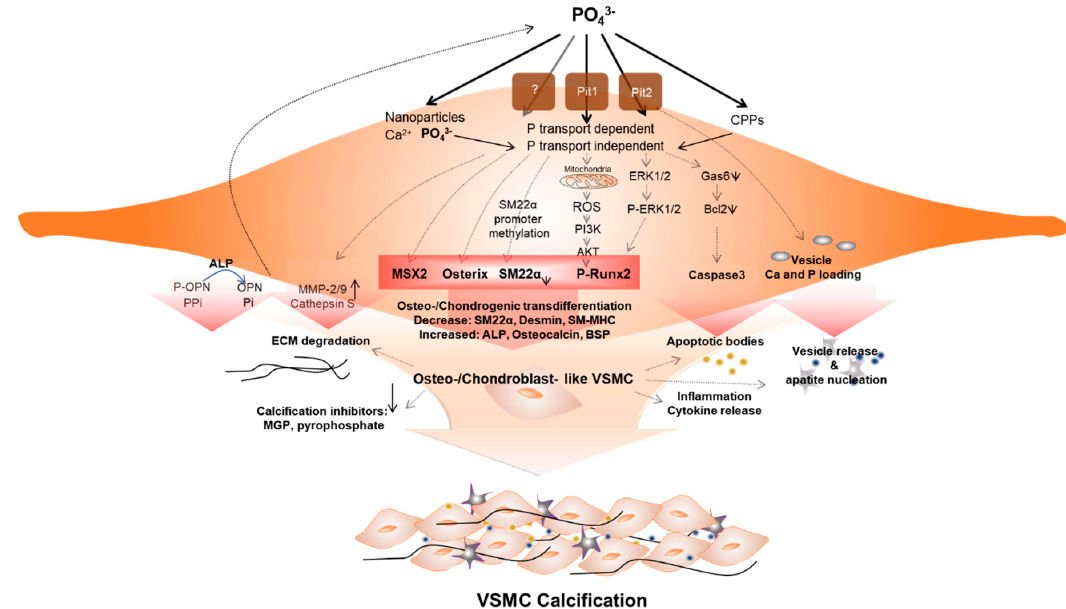
Figure 1. Vascular smooth muscle cells (VSMCs) under hyperphosphatemic conditions. Hyperphosphatemic milieu affects VSMC cellular fate by delivering phosphate (P) into VSMC via phosphate transport (Pit1 or Pit2) dependent, independent (as nanoparticles) or as a form of calciprotein particle (CPP). Followed by diverse signaling pathways that enhance sensitivity of VSMCs to calcification, phenotypic differentiation into osteogenic/chondroblast-like VSMCs occurs. This process includes signaling pathways that induce expression of the osteogenic transcription factors Msh Homeobox 2 (MSX2), Osterix, runt-related transcription factor 2 (Runx2), and alkaline phosphatase (ALP). These changes acceleratedly reduce levels of calcification inhibitors. In addition, ROS generated by P-induced mitochondrial dysfunction activates Runx2 via phosphoinositide 3-kinase (PI3K) / protein kinase B (PKB or AKT) signaling and increased apoptosis promote apoptotic bodies or vesicle release. In addition, extracellular matrix (ECM) degradation and inflammatory cytokine releases are increased. These factors create pro-calcifying environment contributing to vascular calcification.